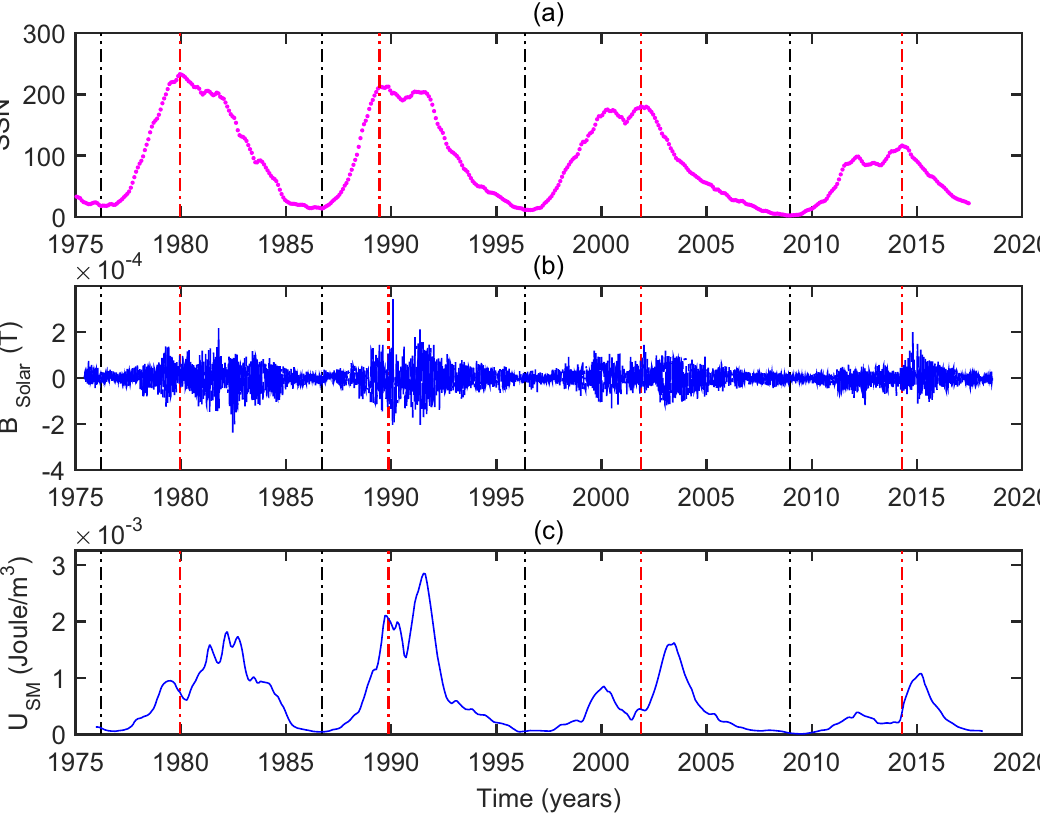
= 2 l Þ for SCs 21–24. The 0 solar